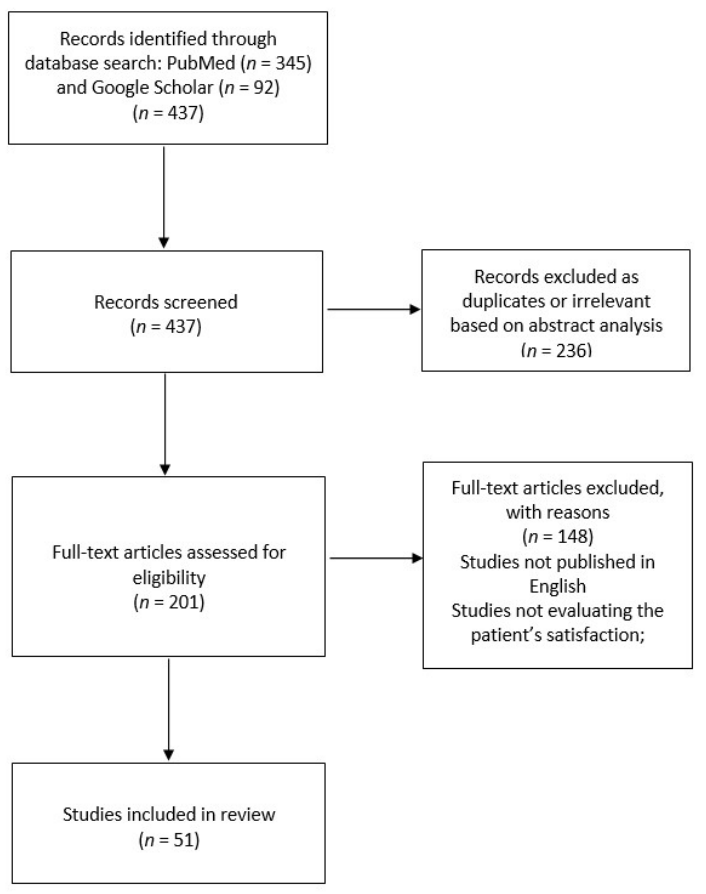
Figure 1. Search and study selection process.